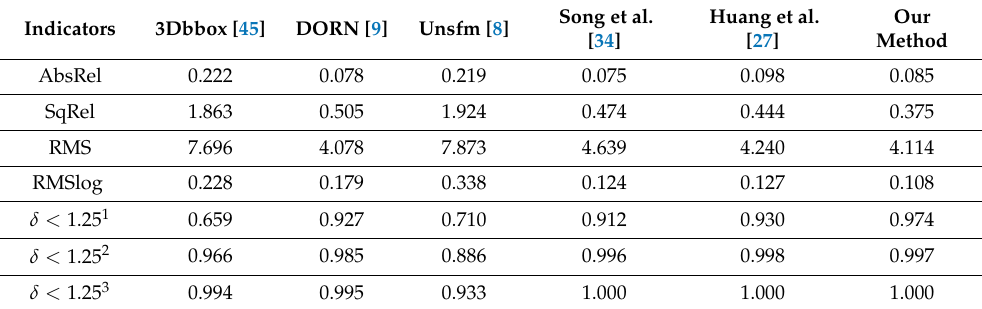
Table 7. Quantitative results of distance estimation for the KITTI dataset.